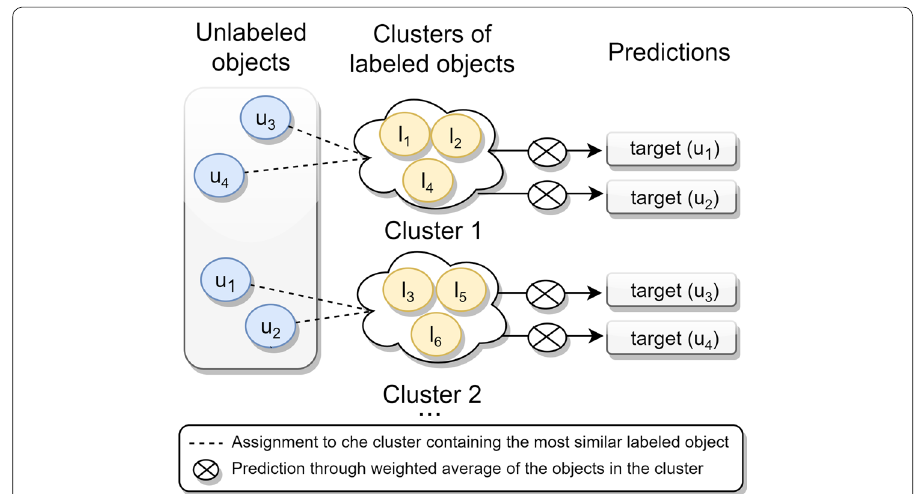
Fig. 4 Graphical representation of the prediction phase of our approach. Each unlabeled object is assigned to the cluster containing the most similar labeled object (dotted lines) and the value of its target attributes are predicted according to a weighted average of the values assumed by the labeled objects in such a cluster (crossed